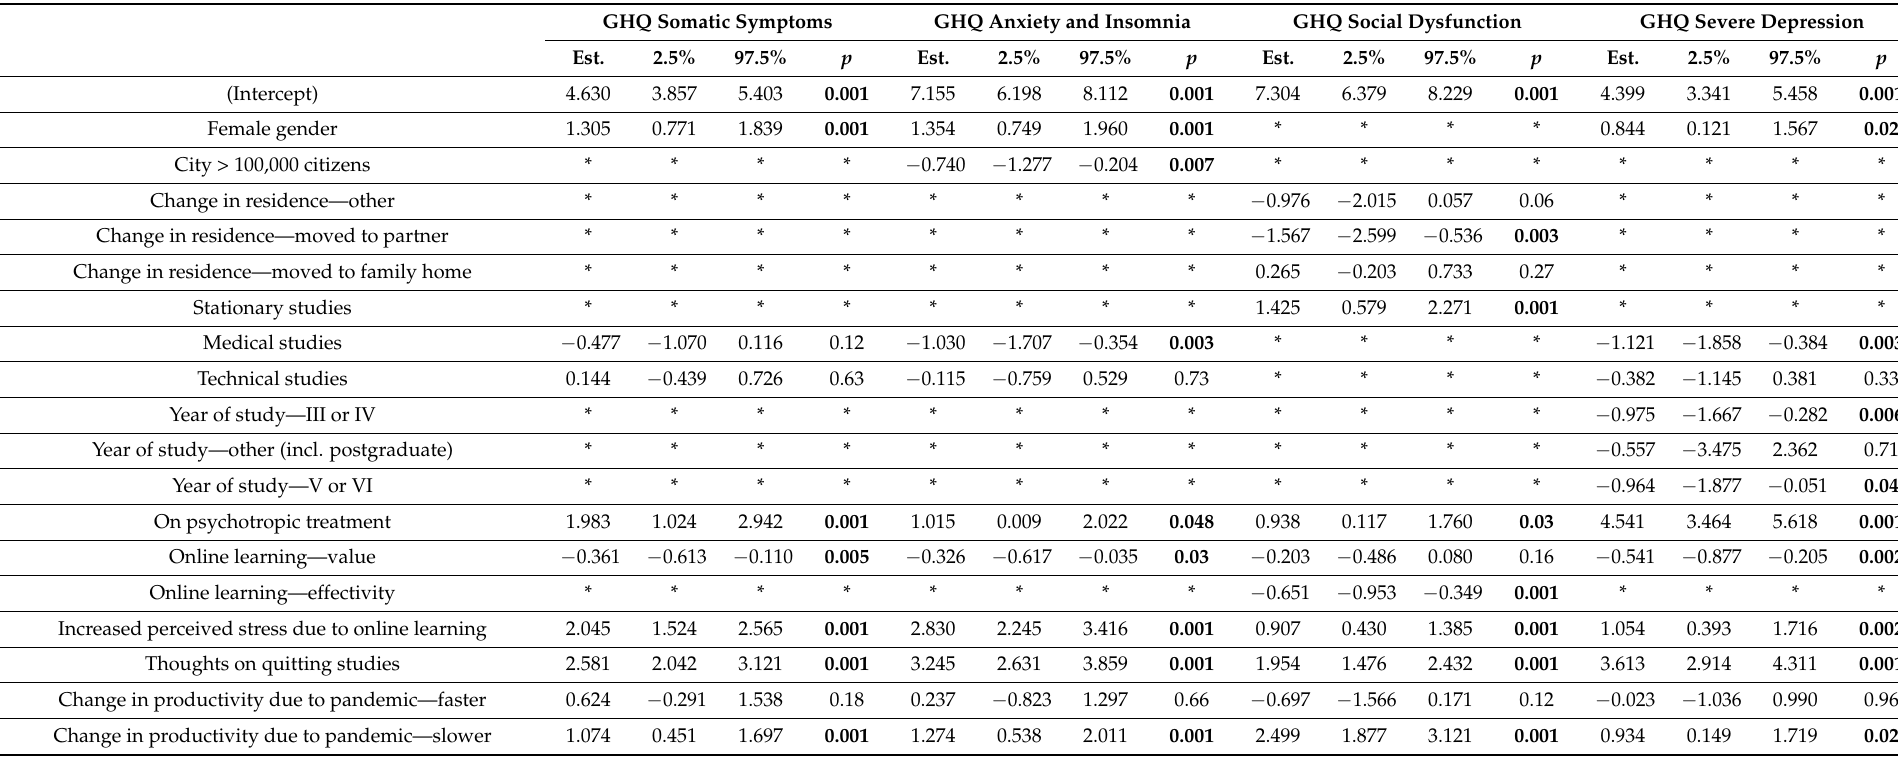
Table 3. Regression models for all 4 Global Health Questionnaire subscales. Standard errors: Robust, type = HC1; Continuous predictors are mean-centered and scaled by 1 standard deviation. Significant p values are marked with bolding in the table ( p ≤ 0.05). Variables marked with * were not included in the final